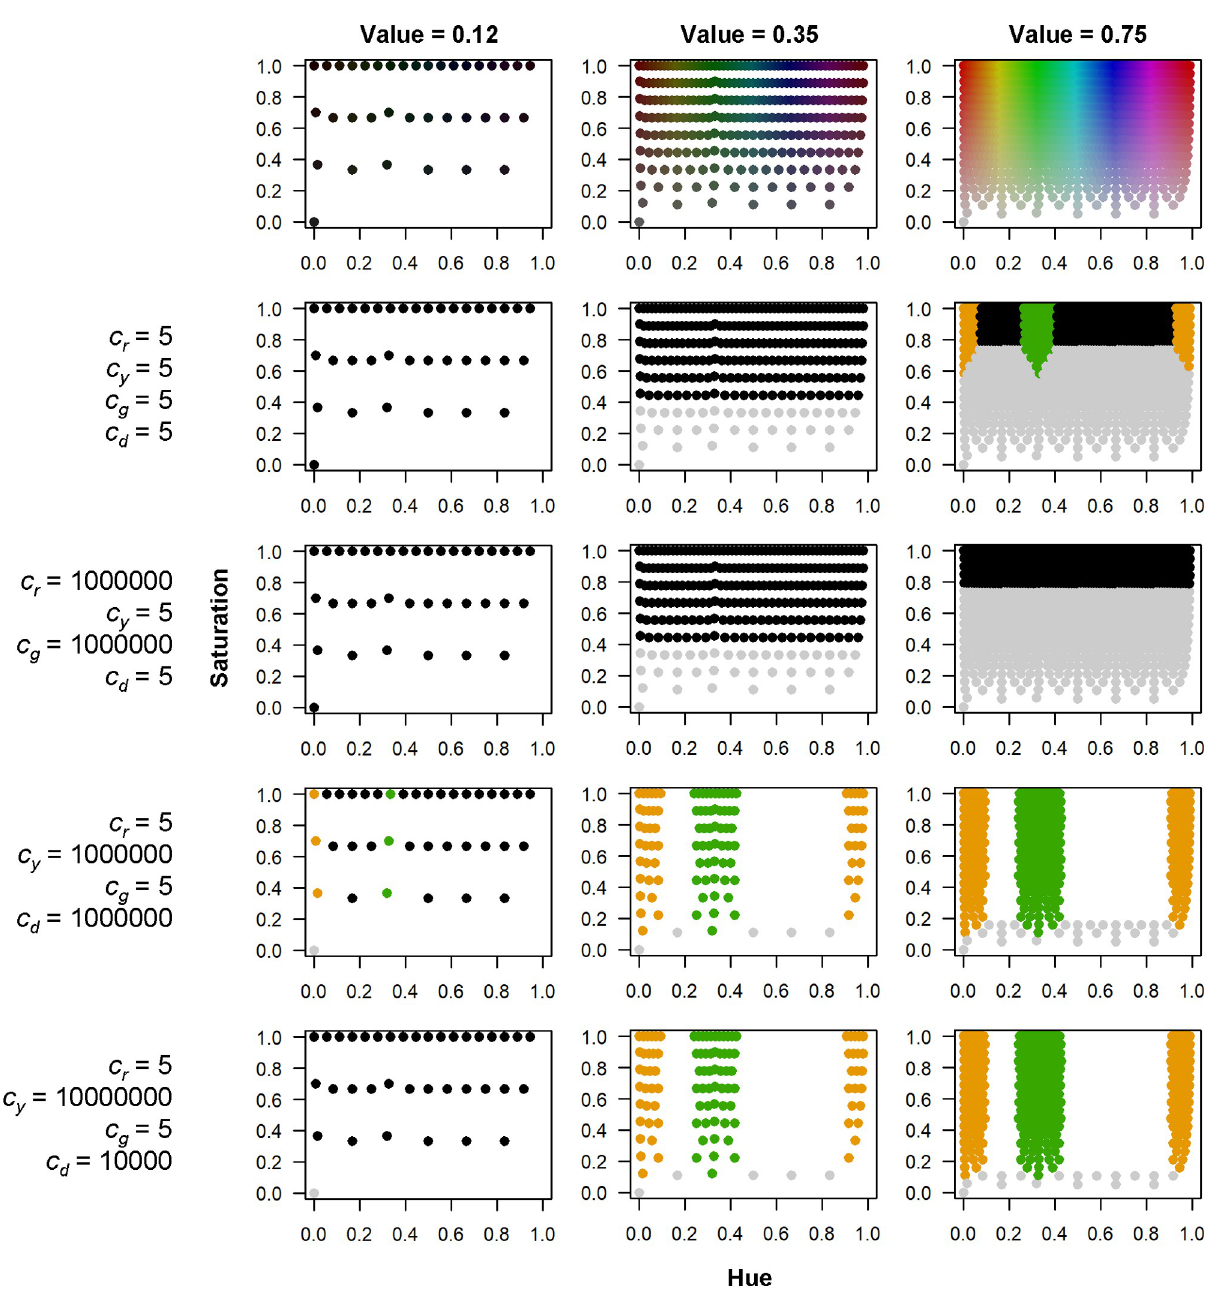
Fig 2. Tree Crown Health (TCH) model classifications in hue, saturation, value (HSV) color space. Plots in top row show color in relation to hue (x- axis), saturation (y-axis), and three levels of value, corresponding to the three columns of plots ( V = 0.12 [left column], 0.35 [middle column], 0.75 [right column]). Plots in rows two through five (bottom row) show how HSV color space is classified using the TCH model equations and different sets of model constants, shown to the left of each row of plots (orange = red model class [red tree crowns], light gray = gray model class [gray tree crowns], dark green = green model class [green tree crowns], black = shadow or dark object model class [crown shadows], and white = background or areas unclassified by the model [i.e., X � t , in Eq (8), where t = 0.1]). The left and middle columns of plots have fewer points because, at lower values, hue and saturation are compressed into smaller portions of HSV space. The bottom row of plots corresponds to the median optimal model constants across all NAIP state x year combinations, and thus is most representative of the best fit models.